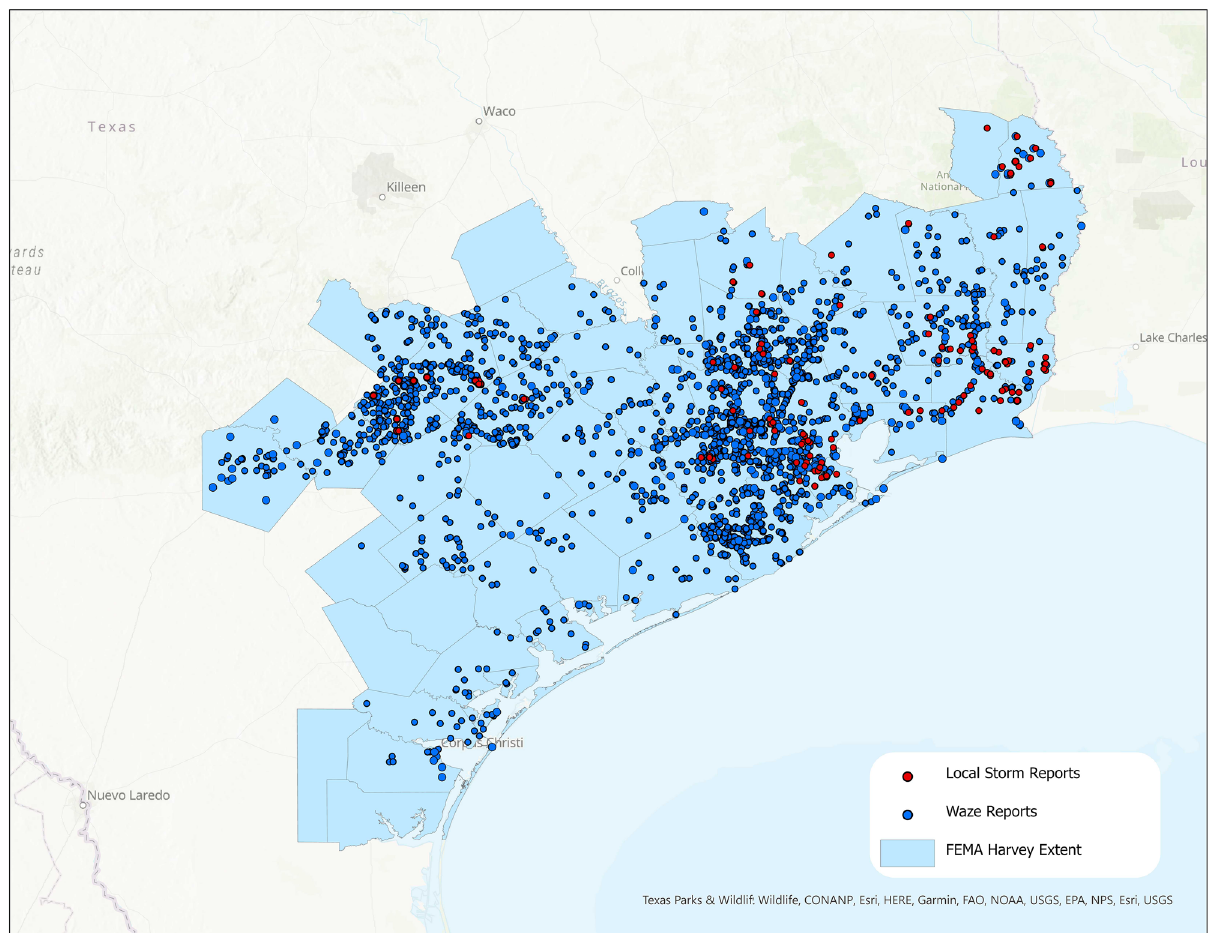
Figure 1. Hurricane Harvey’s spatial extent covering 51 counties in South Texas. FEMA issued the storm’s temporal extent as August 23–September 15, 2017 61 . Waze flood reports (blue) and Local Storm Reports (red) are overlaid on the FEMA extent. Map created using ArcGIS Pro 71